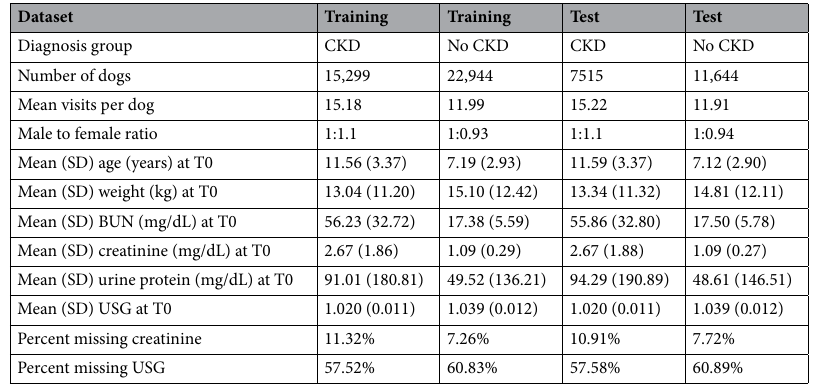
Table 1. Demographics and summaries for the study data set at the time of evaluation (T0). Mean and Standard Deviation (SD) are shown for continuous measures. USG, urine-specific gravity; BUN, blood urea